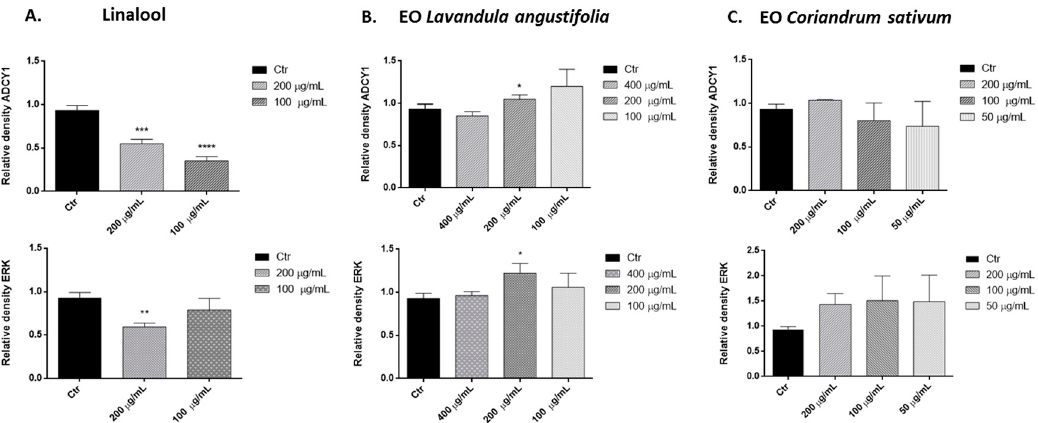
Figure 3. Relative expression levels of the ADCY1 and ERK protein in SH-SY5Y treated with linalool ( A ); L. angustifolia essential oil ( B ); C. sativum essential oil ( C ). Each panel shows densitometric analysis of bands in the control and treated groups. Values are the mean ± SD in each group ( n = 3). * p < 0.05, ** p < 0.01, *** p < 0.001, **** p < 0.0001, compared to control (ANOVA followed by Dunnett’s multiple comparison test).